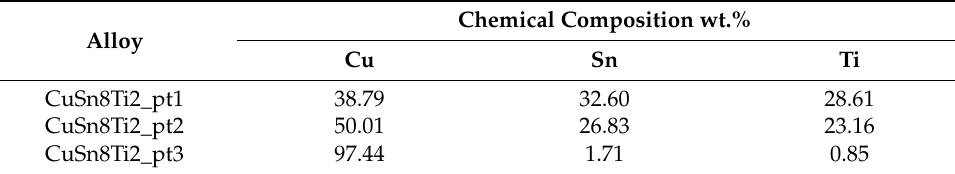
Table 7. Chemical composition EDS wt.% of CuSn8Ni3Ti2 alloy for the Figure 6d image. Table 5. Chemical composition EDS wt.% of CuSn8Ti2 alloy for the Figure 6b